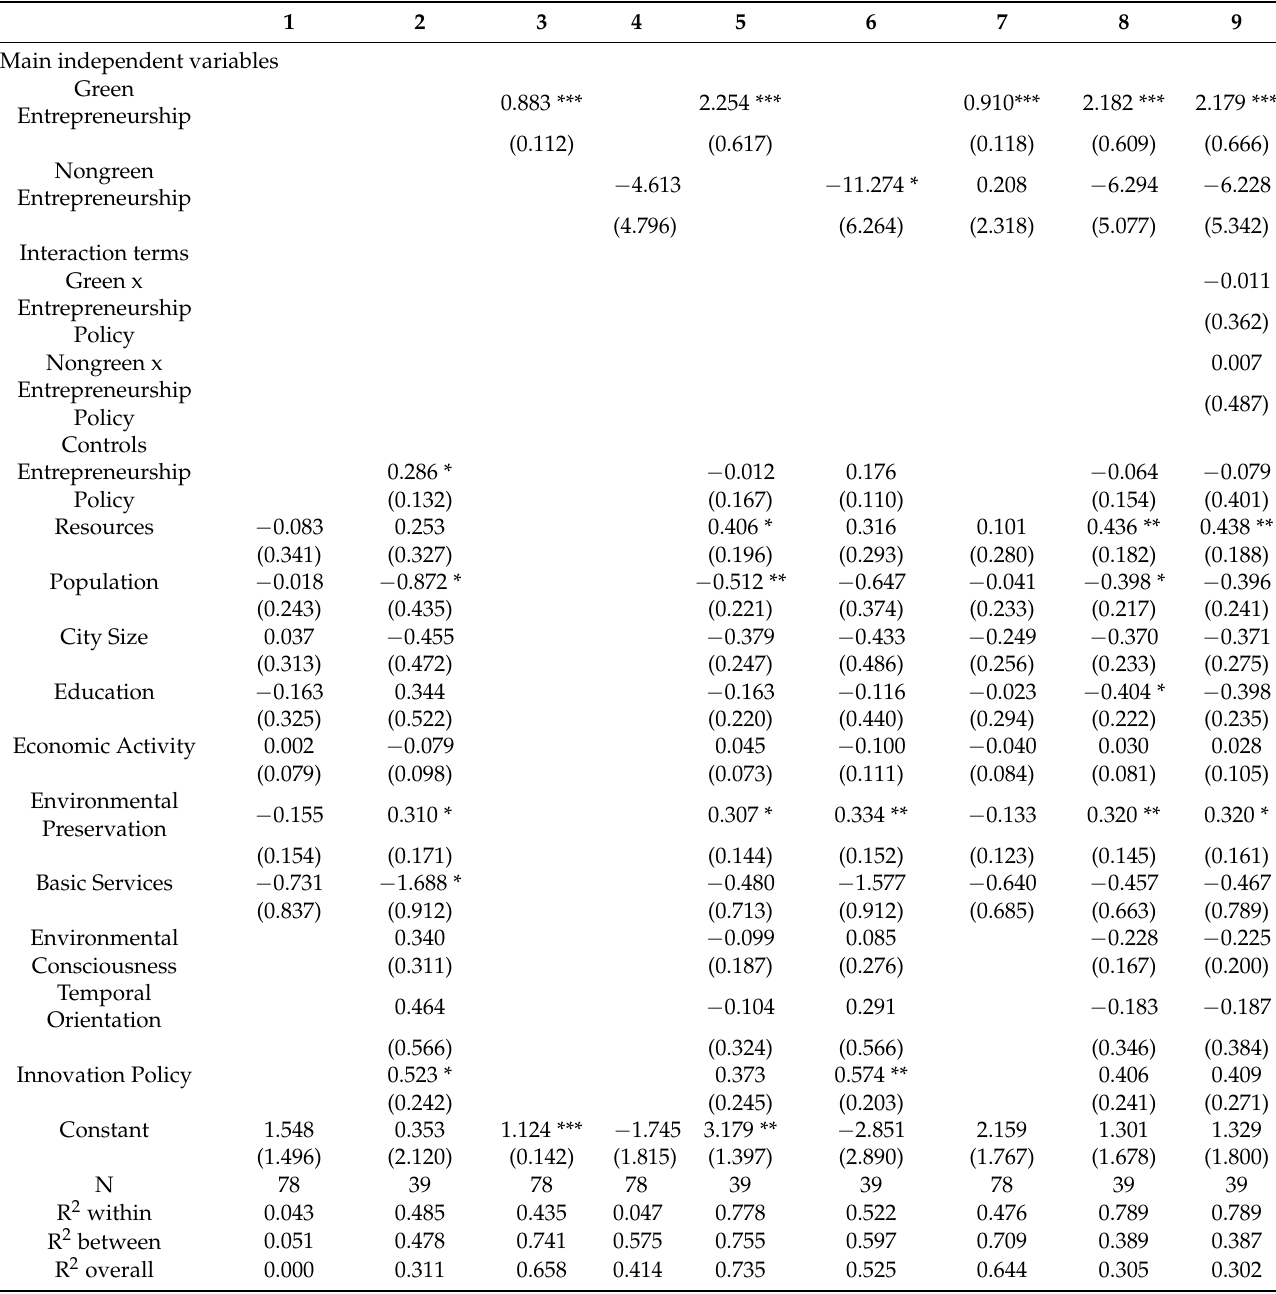
Table A3. Regression analysis (DV = social